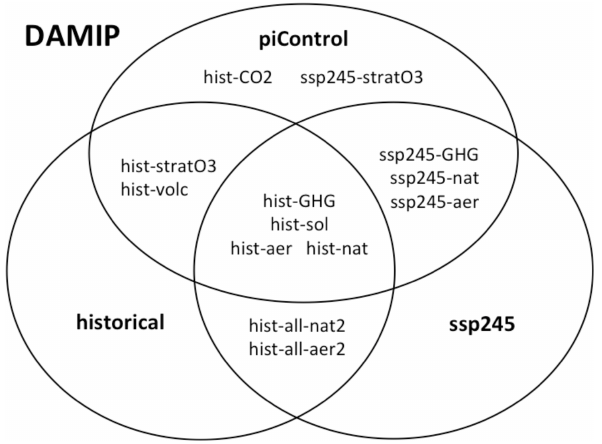
Figure 8. A view of DAMIP with experiments placed in sets ac- cording to the forcing constraints they share with the external ex- periments: piControl, historical, and ssp245.